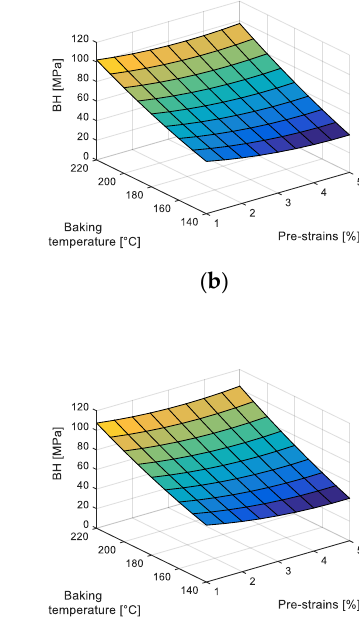
Figure 3. Bake hardening behavior of the IF DX 51D steel. ( a ) Baking time 10 min; ( b ) baking time 15 min; ( c ) baking time 20 min; ( d ) baking time 30 min.